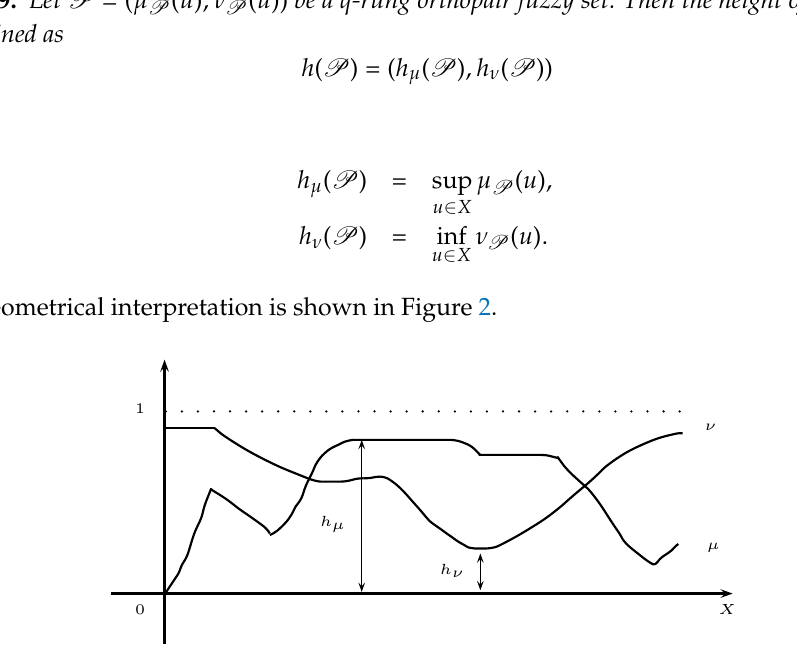
q=4 q=2 q=3 Figure 2.1: Spaces of acceptable q -rung orthopairs Definition 2.7. Let P = ( µ P ( u ) , ν P ( u )) be a q -rung orthopair fuzzy set. Then the cardinality of P is denoted by Card( P ) , is defined as